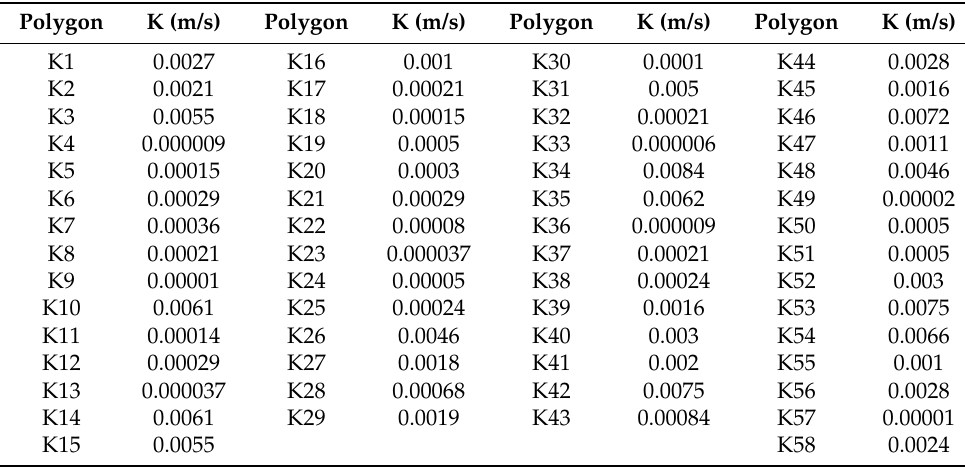
Table 4. Hydraulic conductivity values assigned to model polygons.